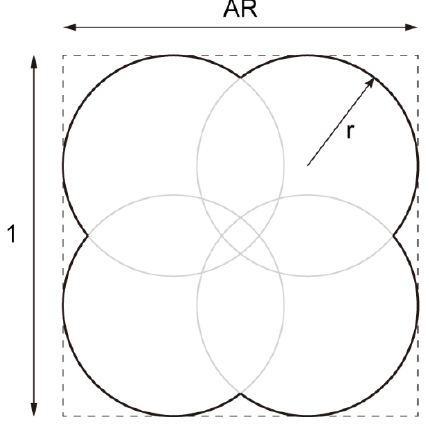
Figure 2. Schematic of the four-particle model to form a particle clump.